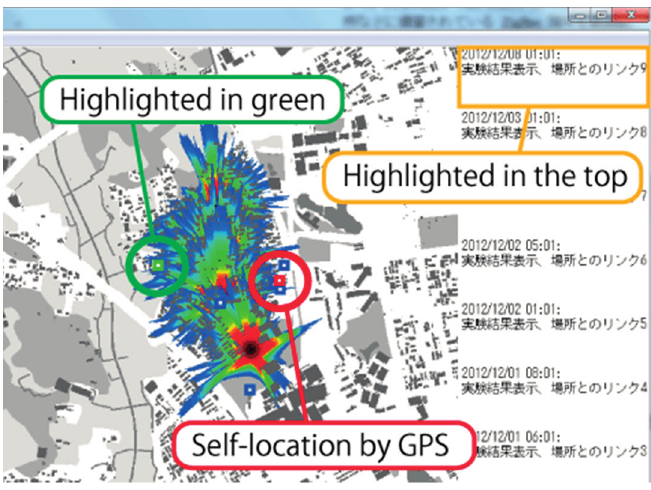
Figure 5. Screen of the proposed